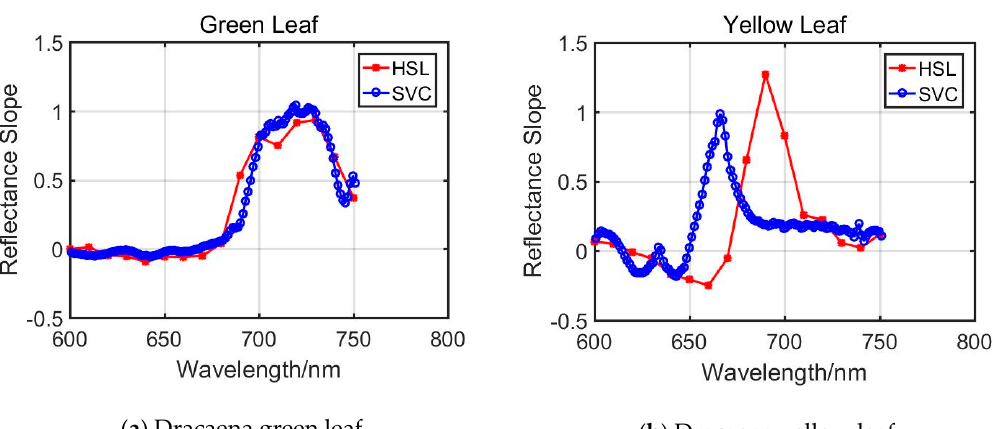
Figure 7. First derivative of the spectral reflectance versus spectral values of dracaena green and yellow leaf measured by the AOTF-HSL and the SVC spectrometer. ( a ) Dracaena green leaf, ( b ) Dracaena yellow leaf.